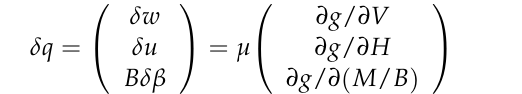
Figure 3. Schematic two ‐ dimensional representation ( M/M M =0) of the model surfaces, force state and plastic potential introduced in the proposed macro ‐ element model for the plate anchor.